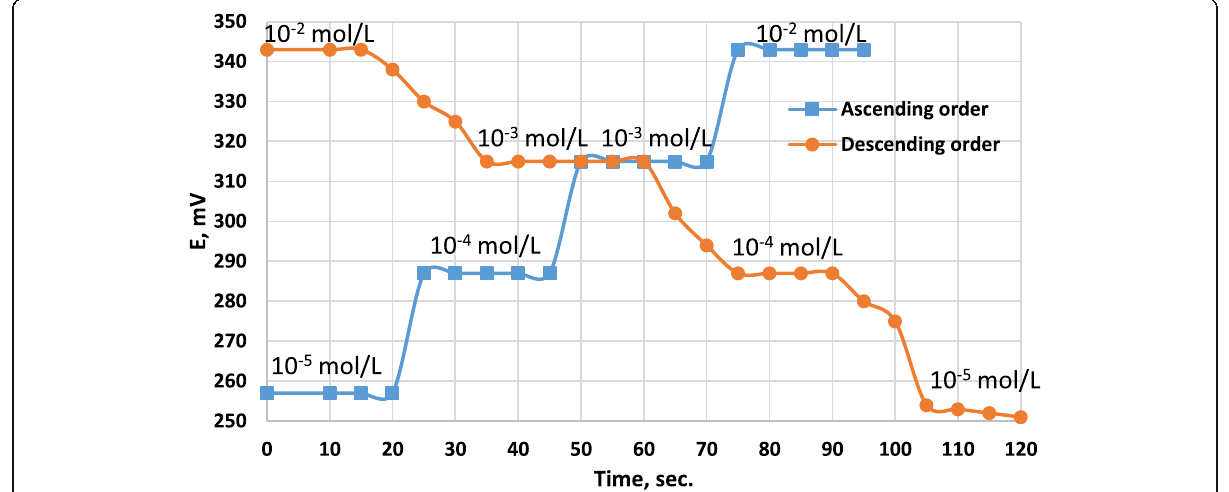
Fig. 5 Dynamic response of the proposed Cd(II)-CPE sensor for step changes in Cd(II) concentration (from low to high and vice